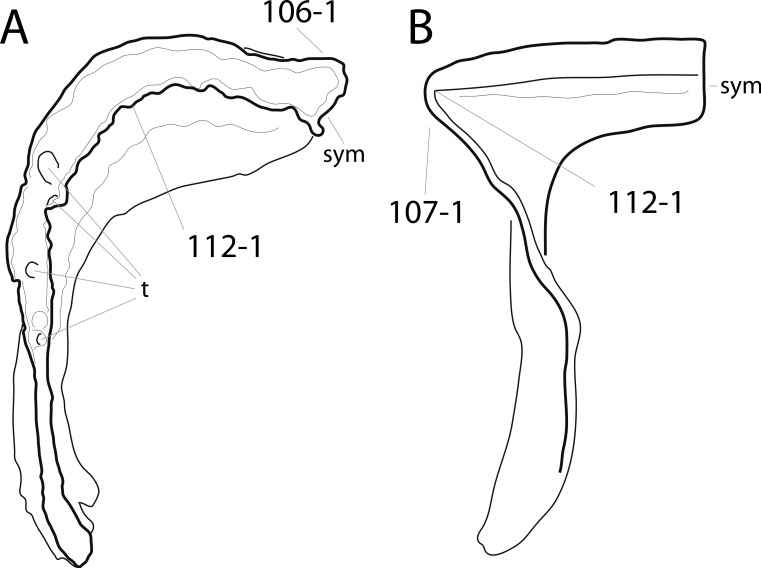
Diplodocimorph dentaries.Left dentary of Dicraeosaurus hansemanni MB.R.2372 (A), and Nigersaurus taqueti MNN GAD512-10 (B; traced from Sereno et al., 2007) in dorsal view. Note the labial tubercle in Dicraeosaurus (A; C106-1), the dentigerous portion that expands laterally in Nigersaurus (B; C107-1), and the anterolaterally displaced tooth row, compared to the usual curvature in both taxa (C112-1). Abb.: sym, symphysis; t, tooth. Scaled to the same anteroposterior length.